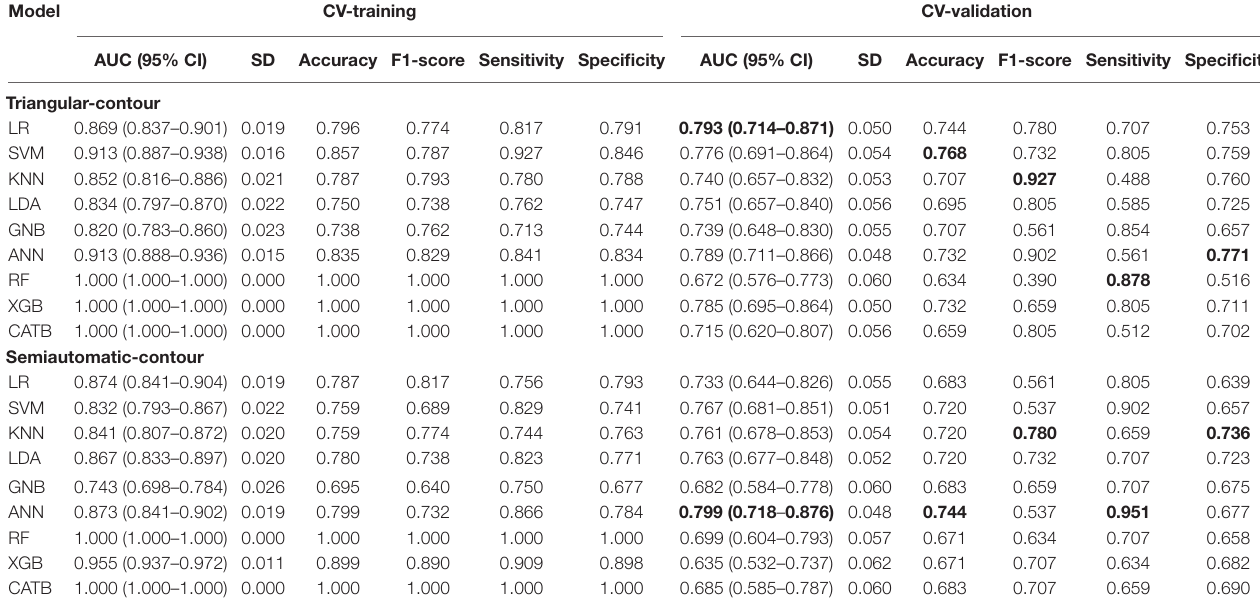
TABLE 2 | Performance of 9 machine learning models in the fivefold CV training and validation